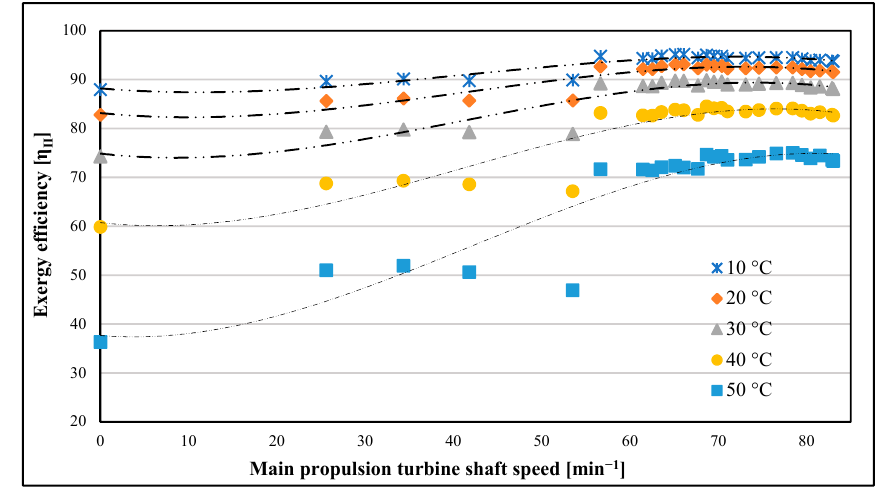
Figure 7. Exergy efficiency with surrounding temperature changes. Figure 7. Exergy e ffi ciency with surrounding temperature